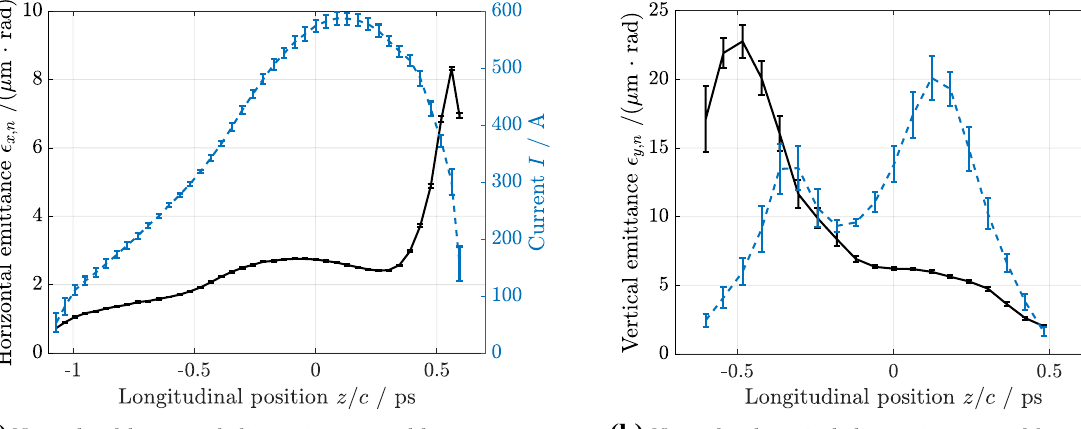
Figure 4. Normalized slice emittance. The errorbars indicate one standard